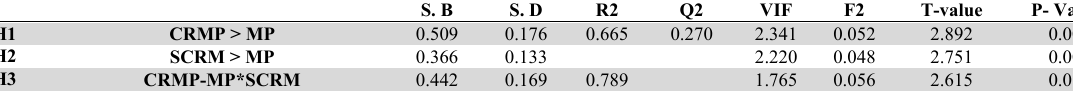
Hypothesis Testing